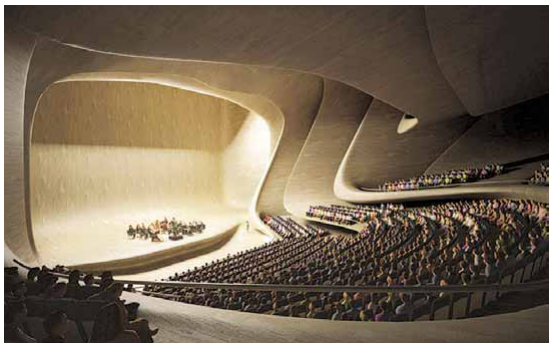
20 pav. Gaidaro Alijevo kultūros centro salės vaizdas, Baku, Azerbaidžanas, archit. Z. Hadid, statomas nuo 2007 m. Fig. 20. Gaidar Aliyjev cultural center, view of the hall, Baku, Azerbaijan, archit. Z. Hadid, since